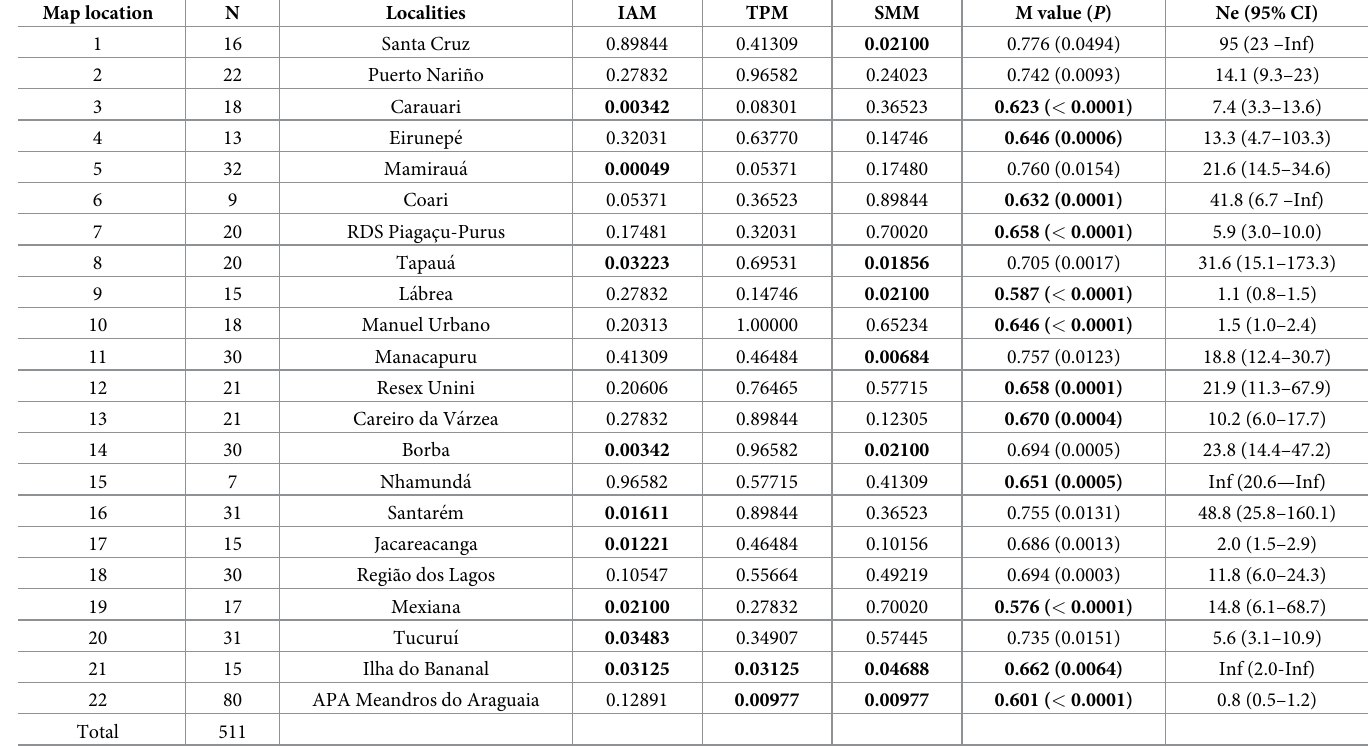
Table 4. Bottleneck metrics for Arapaima gigas by